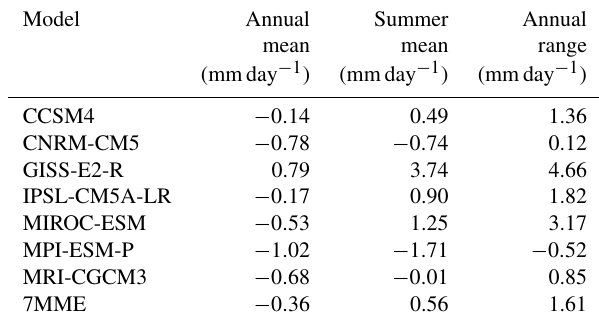
Table 3. Annual mean, austral summer (DJF) mean and annual range of precipitation change over the region of 20–5 ◦ S, 120– 145 ◦ E. The area averaged value is calculated based on the areas where the signal-to-noise ratio exceeds